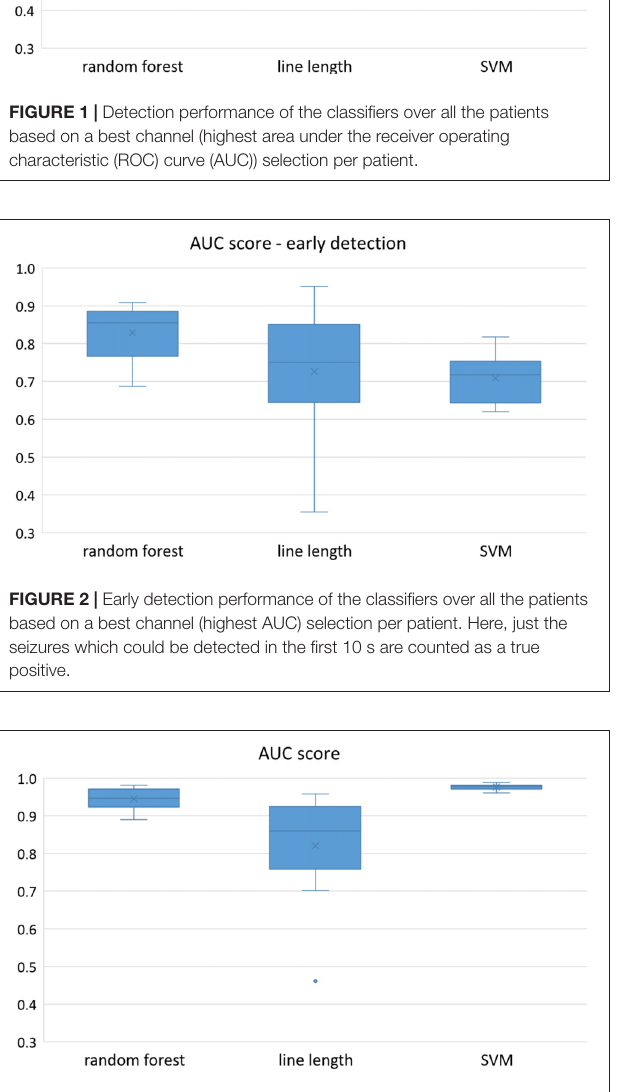
FIGURE 3 | Detection performance of the classifiers over all the patients in multichannel mode.